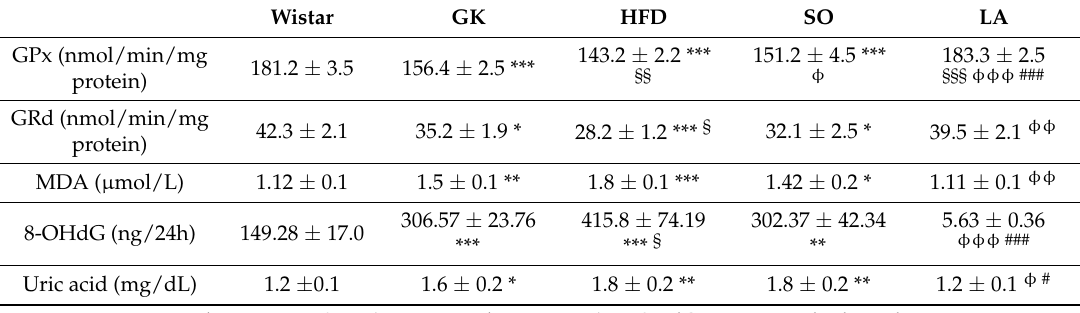
Table 3. Effect of α -lipoic acid on hepatic antioxidant enzymes, systemic markers of oxidative stress, and uric acid levels on Goto-Kakizaki rats fed a high fat-diet compared with age-matched Wistar rats and diabetic GK rats. Wistar GK HFD SO